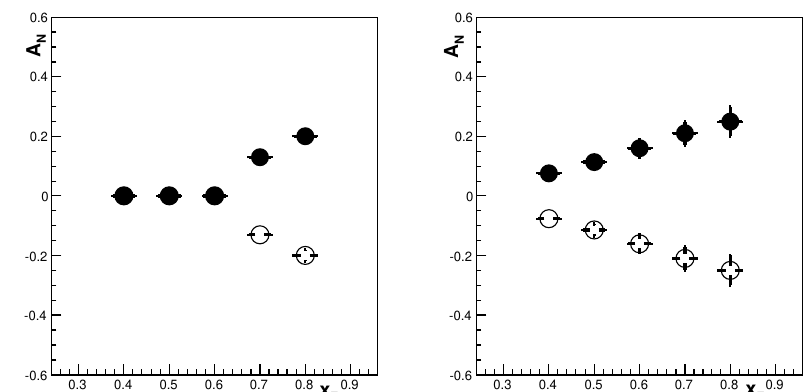
Figure 3. The value of asymmetry ( A y ≡ A N ) can be obtained in a month of operation of MPD on a beam of polarized protons with a luminosity of 10 31 cm − 2 s − 1 (an order of magnitude less than the √ s = 4 GeV (left p T > 1 . 4 GeV / c, right p T > 1 . 6 GeV / design) and energy